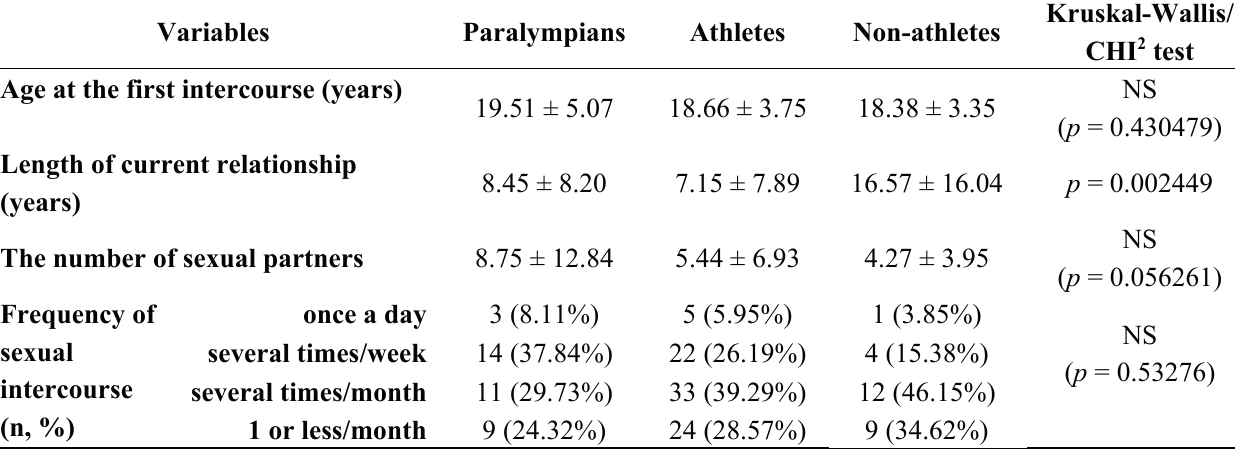
Table 2. Sexual behaviours in the study population (mean ± SD;